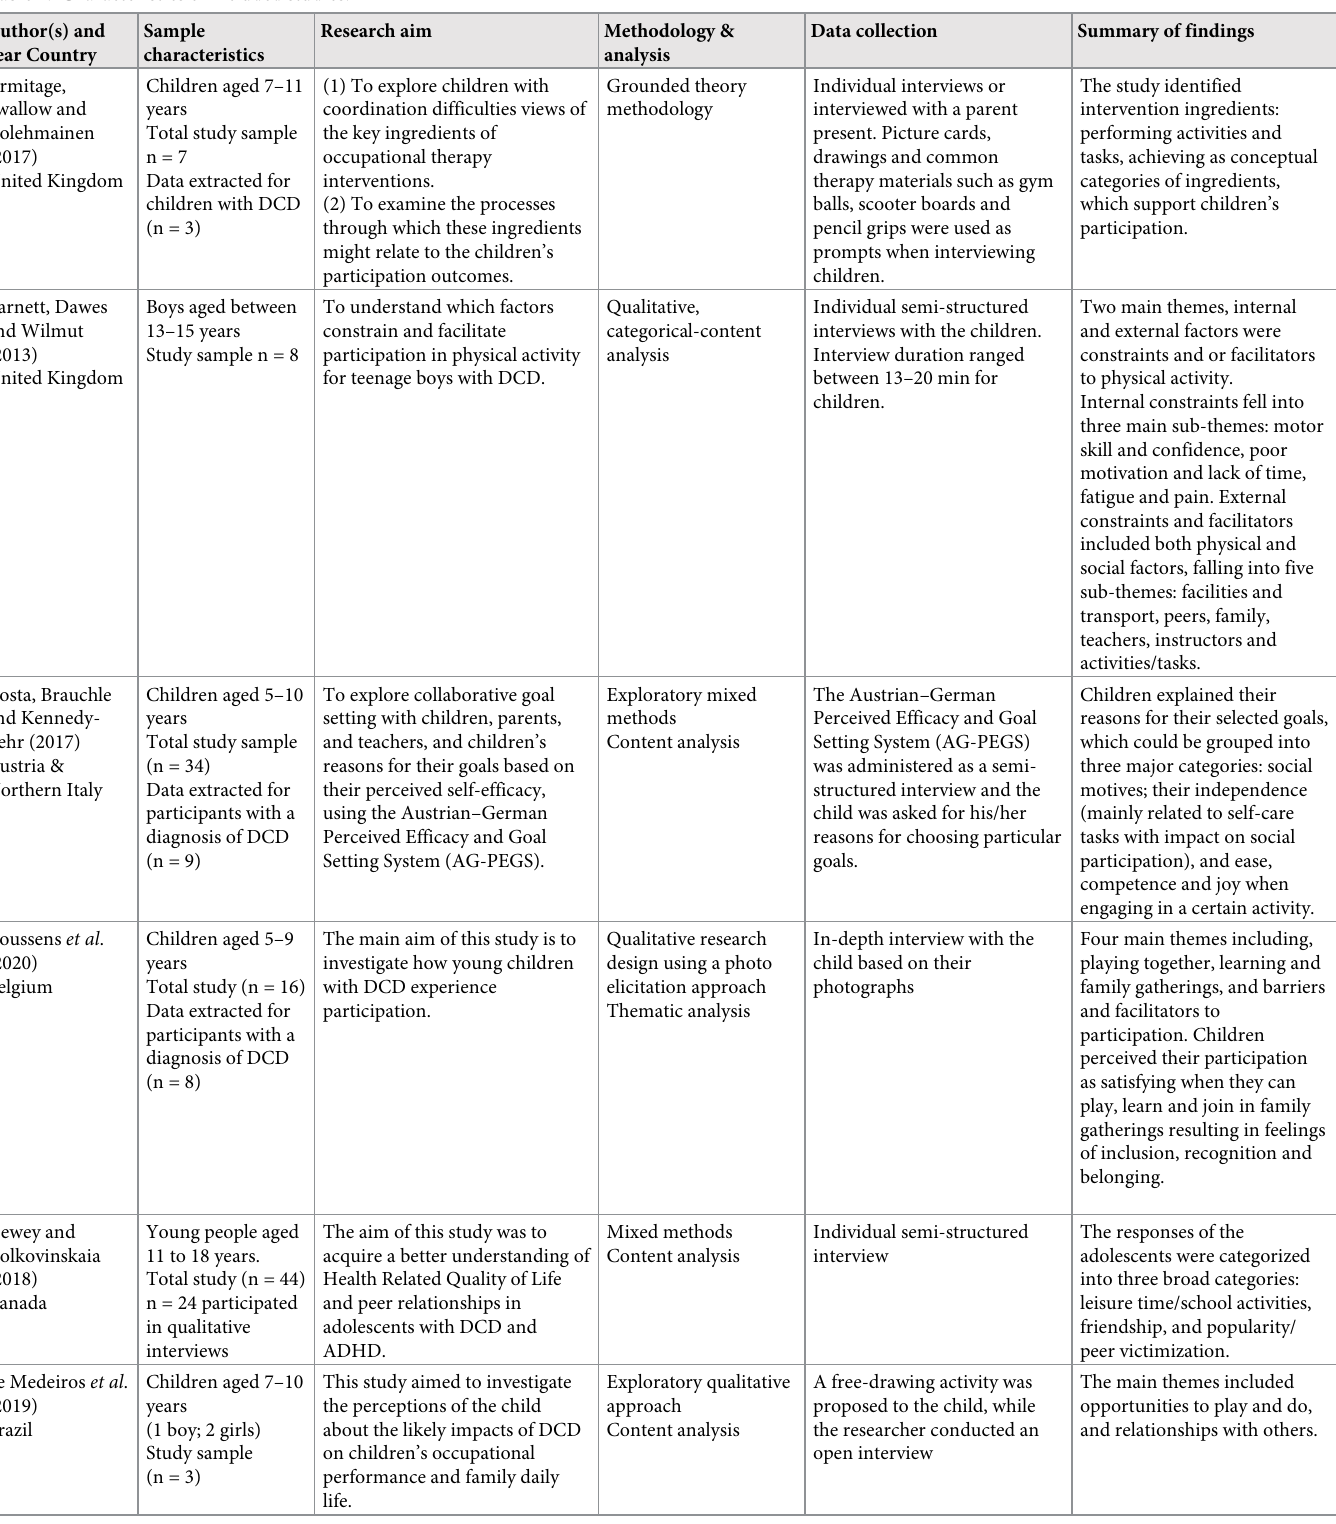
Table 1. Characteristics of included